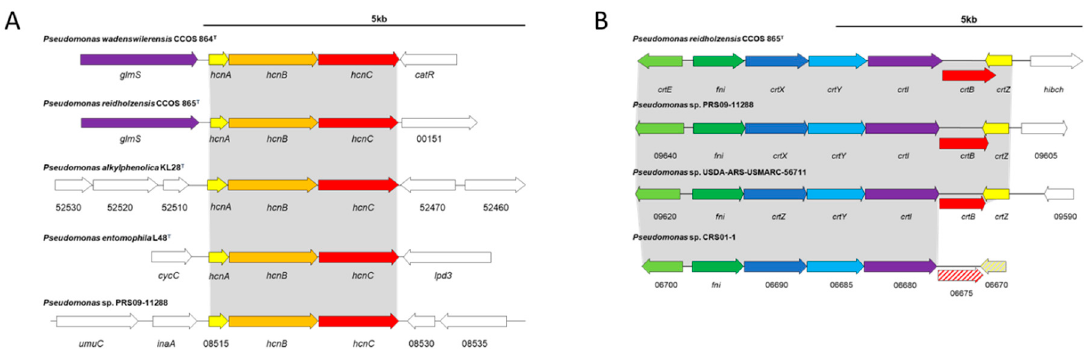
Figure 4. Secondary metabolites. ( A ): Gene cluster for hydrogen cyanide (HCN) biosynthesis. Orthologous genes are marked in the same color. Identical gene arrangements within the genomes are shaded in grey. ( B ): Carotenoid gene cluster for the synthesis of zeaxanthin. The grey shading shows identical arrangements within the genomes, while orthologous genes are marked in the same color. Dashed color indicates weak levels of sequence identity.